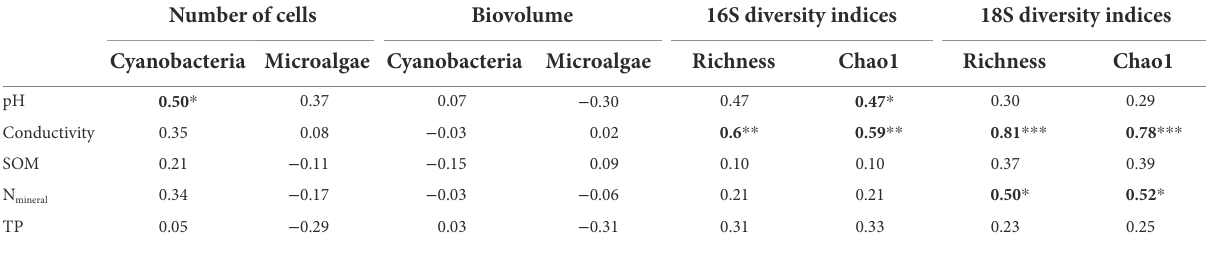
TABLE 2 Correlations between soil chemical parameters and diversity and abundance measurements assessed by Pearson correlation